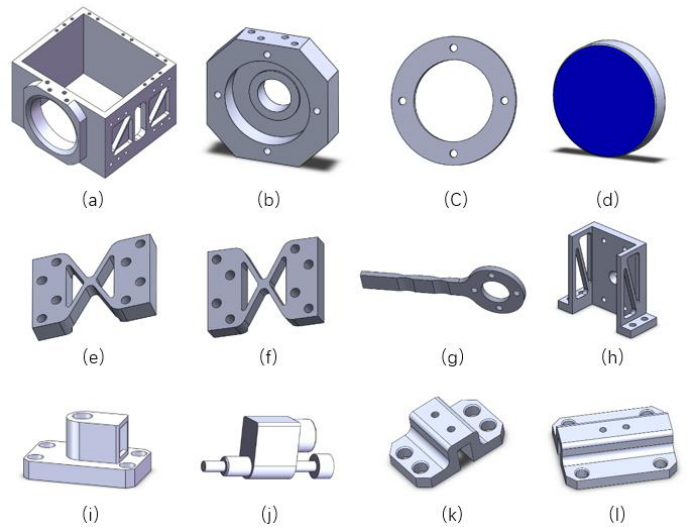
Figure 2. 3D model of the parts of the swing micro-mirror structure: ( a ) framework; ( b ) mirror cell; ( c ) mirror fixed plate; ( d ) mirror; ( e ) flexible hinge A; ( f ) flexible hinge B; ( g ) flexible arm; ( h ) actuator connecting plate; ( i ) actuator keep plate; ( j ) actuator; ( k ) supporting foot A; ( l ) supporting foot B.